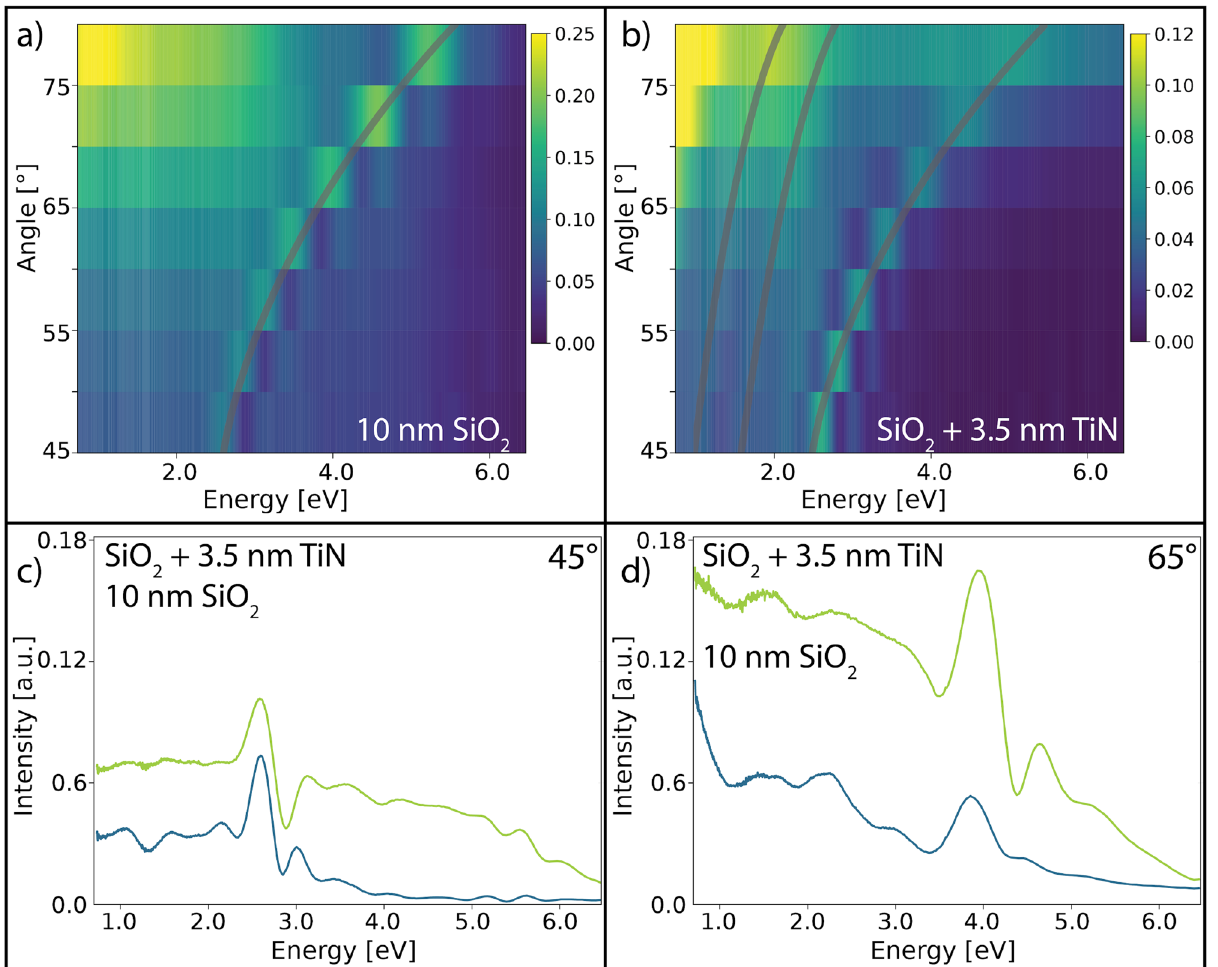
Figure 3. Inverse opal reflected intensity. Reflected intensity measured by VASE. ( a ) A strong photonic mode is present in the 10 nm SiO 2 inverse opal, which ( b ) is somewhat attenuated after coating with 3.5 nm of conductive and refractory TiN. Two additional weak low energy modes can be seen in ( b ) after TiN coating. Comparison of the reflected intensity of two inverse opal samples measured at ( c ) 45° and ( d ) 65°. A small red- shift in photonic resonance after TiN deposition is visible at